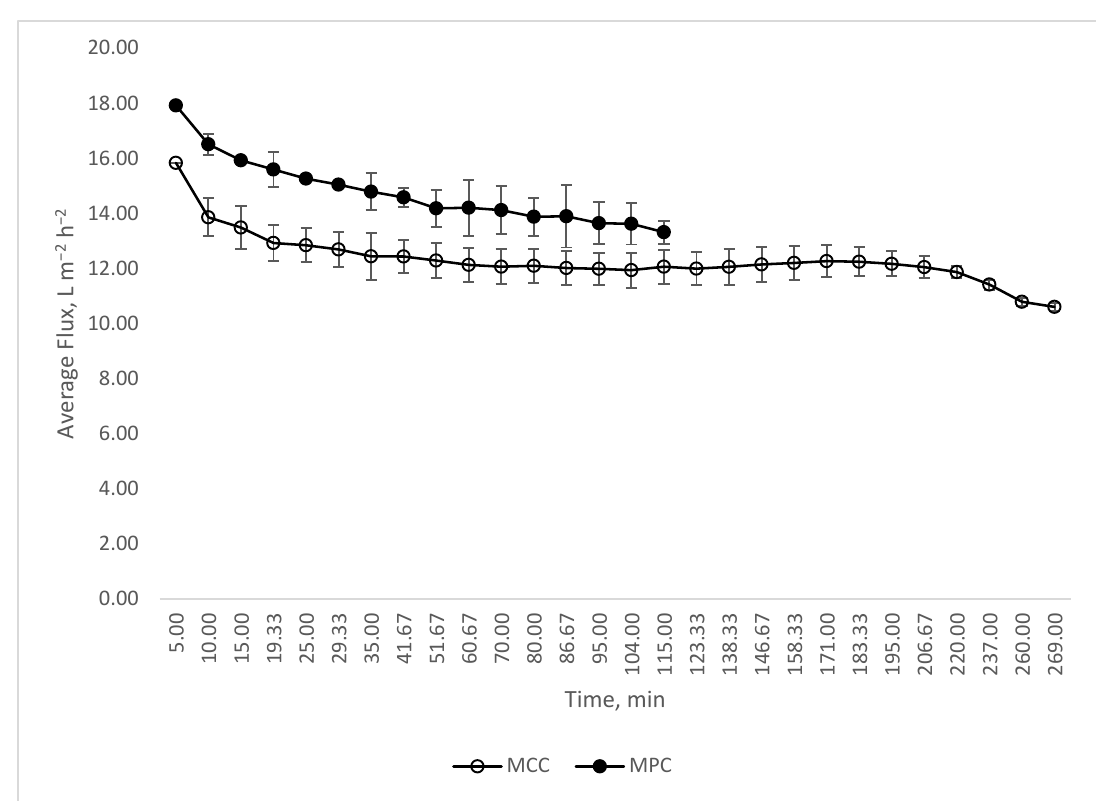
Figure 2. Average flux rate of MCC and MPC runs ( n = 3). Bars depict standard error of mean.